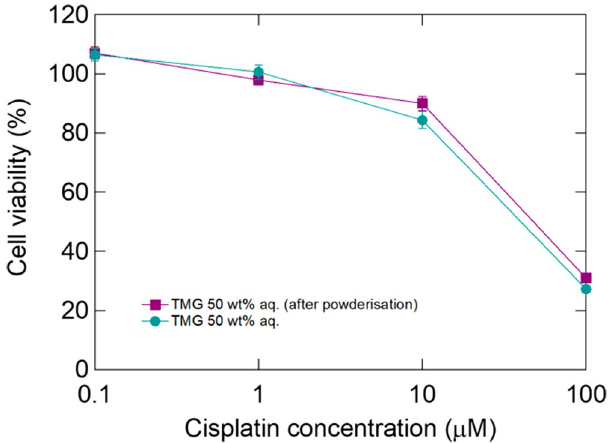
Figure 4. MDA-MB-231 cell viability after treatment with cisplatin dissolved in 50 wt% TMG aq., with or without powderisation. (n = 3, biologically